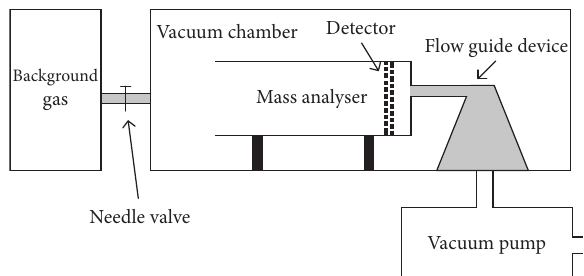
Figure 8: Block diagram of a modified vacuum system.